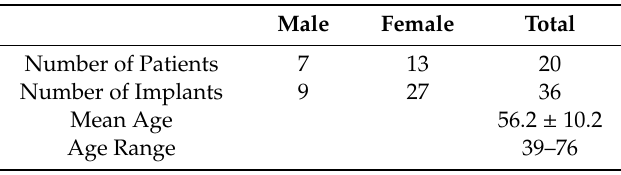
Table 1. Demographic data and clinical